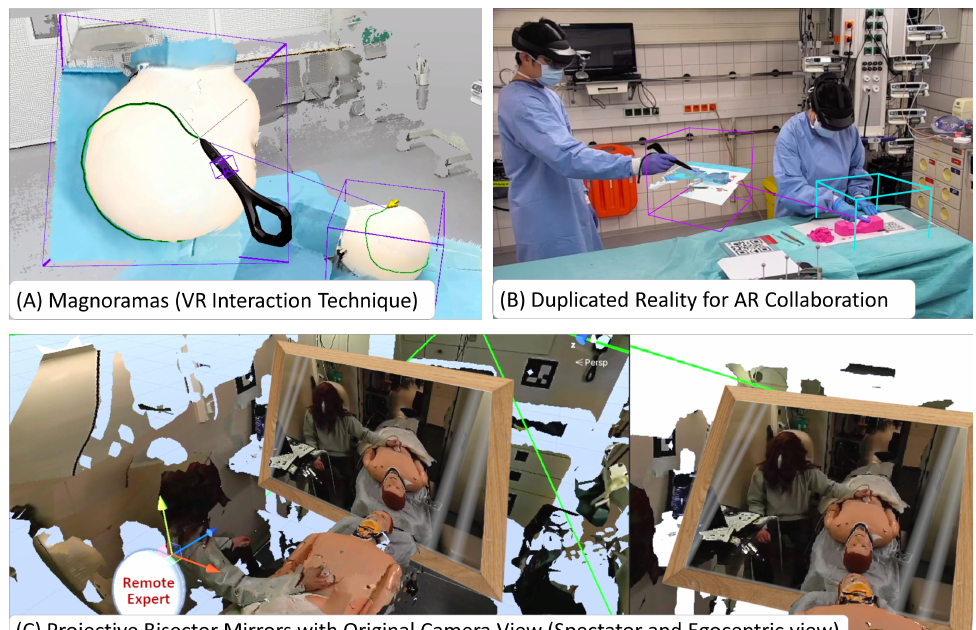
Figure 4. Interaction Techniques Unique to ArTekMed : ( A ) The Magnorama creates a dynamic 3D cutout from the real-time reconstruction and allows the user to interact and explore the space while intuitively creating annotations at the original region of interest within the duplicate. ( B ) The principle of Magnoramas translates well into AR. The resulting technique of Duplicated Reality allows co-located collaboration in tight spaces, even without a remote user. ( C ) For remote users to experience more details of the patient and their surroundings, ArTekMed deploys Projective Bisector Mirrors to bridge the gap between reality and reconstruction through the mirror